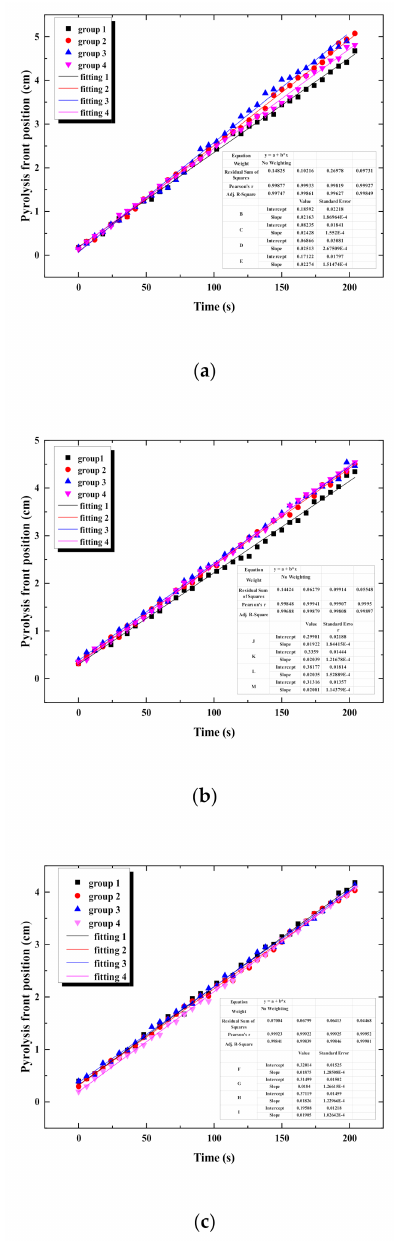
Figure 9. Pyrolysis front position of single cable with di ff erent core numbers versus time. ( a ) Two cores; ( b ) three cores; ( c ) four